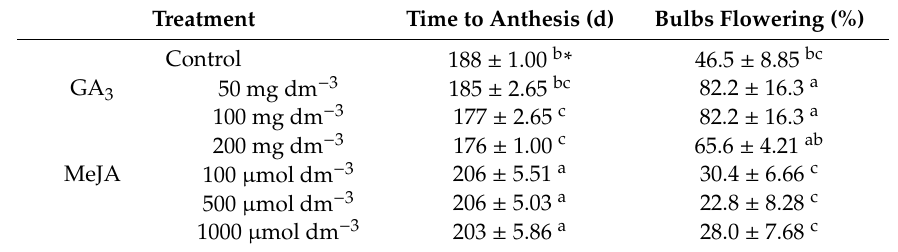
Table 2. E ff ects of GA 3 and MeJA on anthesis time and the bulb flowering percentage of × Amarine tubergenii “Zwanenburg”.